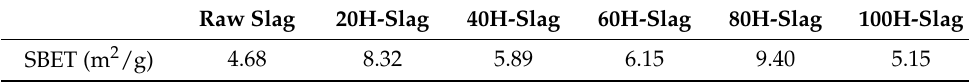
Table 2. The BET specific surface area of the pretreated